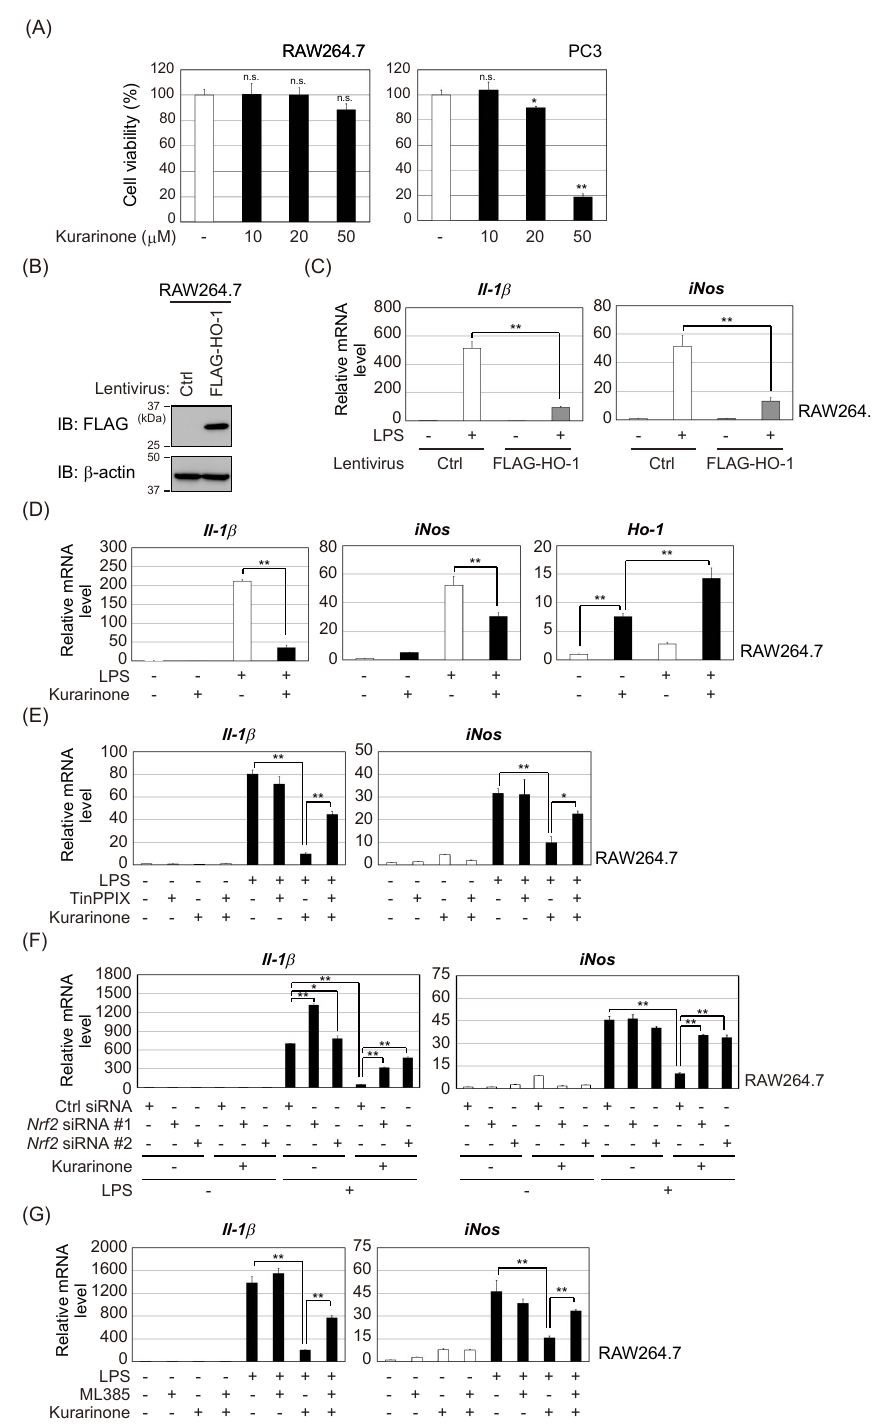
Figure 4. Kurarinone suppressed the expression of Il-1 β and iNos mRNA in LPS-stimulated RAW264.7 macrophages by up-regulating HO-1 expression. ( A ) RAW264.7 and PC3 cells were exposed to the indicated doses of kurarinone for 24 h. Cell viability was measured using the WST-8 cell proliferation assay. Results were shown as the mean ± S.D. ( n = 3). Significant di ff erences are indicated as ** p < 0.01, * p < 0.05 vs. the group without kurarinone-treatment. n.s.: not significant. ( B ) RAW264.7 cells and RAW264.7 / FLAG-HO-1 cells were subjected to immunoblotting with the indicated antibodies. Ctrl, control ( C ) RAW264.7 and RAW264.7 / FLAG-HO-1 cells were treated with 100 ng / mL of LPS for 6 h. The expression level of each gene was assessed by qPCR. Results represent the mean ± S.D. ( n = 3). ( D ) RAW264.7 cells were pretreated with 50 µ M kurarinone for 6 h and then incubated with 100 ng / mL of LPS for 6 h. The expression level of each gene was assessed by qPCR. Results are shown as